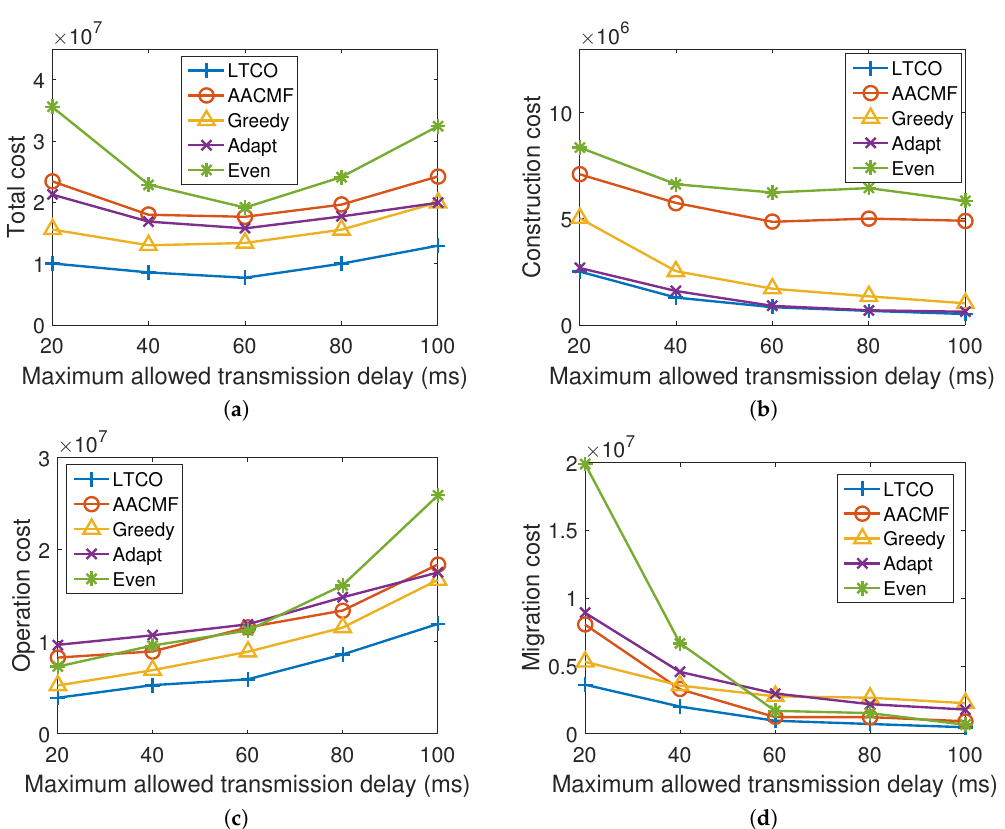
Figure 5. Impact of varied parameter D for randomly generated mobility